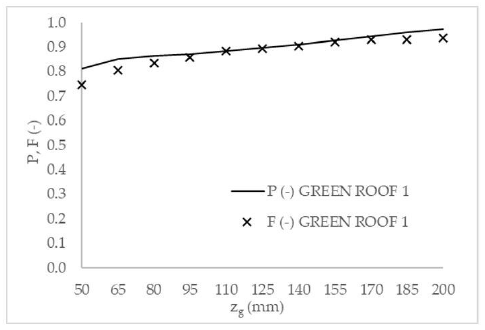
Figure 2. Comparison between probability ( P ) and frequency ( F ) distribution function of water content into growing medium varying its thickness ( z g ), GREEN ROOF 1.